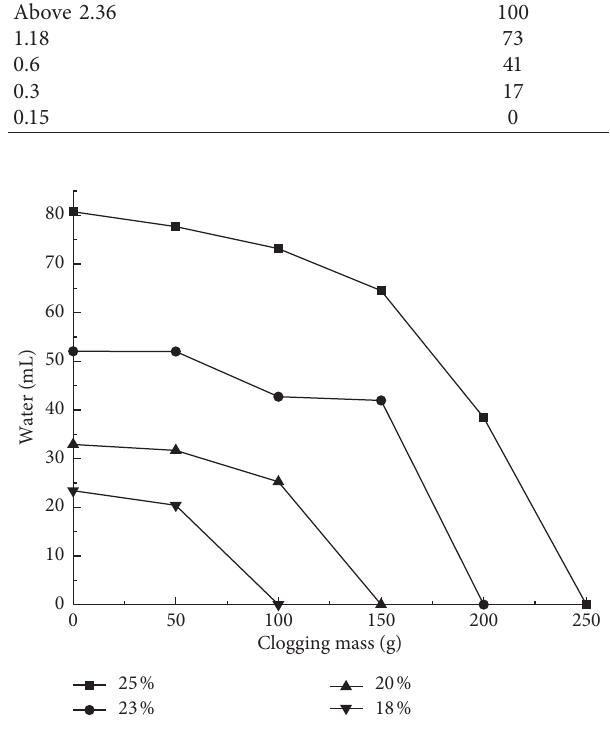
Figure 4: MDC influenced by clogging.